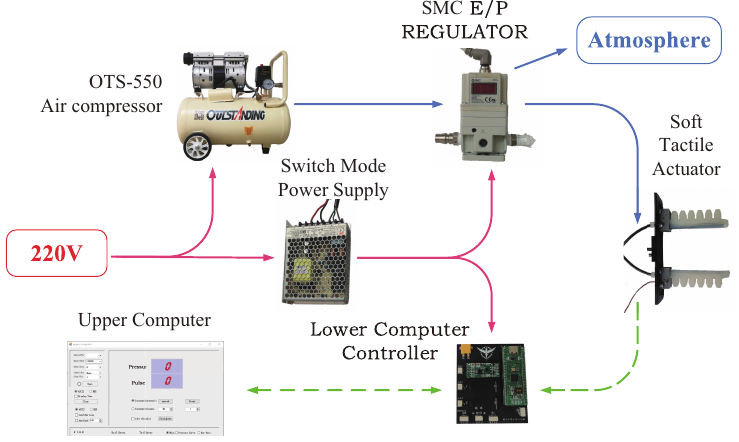
Figure 6. Experimental platform of the